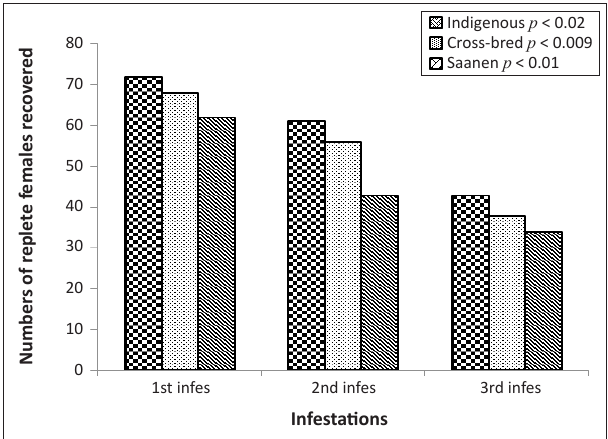
FIGURE 3: Replete females recovered during three consecutive infestations of Rhipicephalus appendiculatus from South African Indigenous goats (Nguni), cross-bred and Saanen